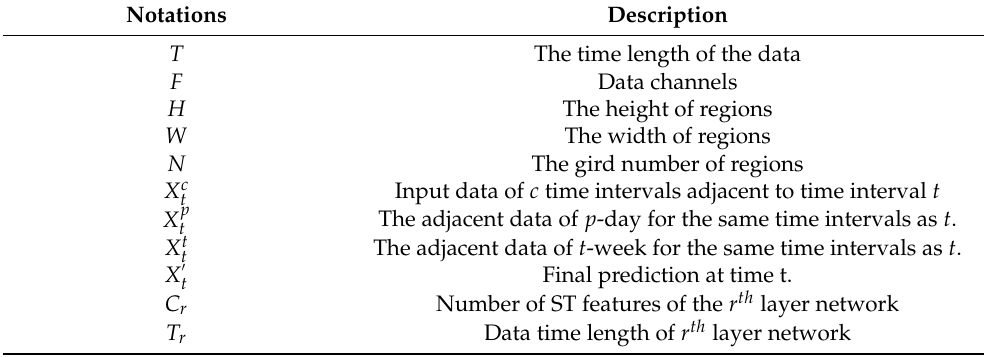
Table 1. Summary of